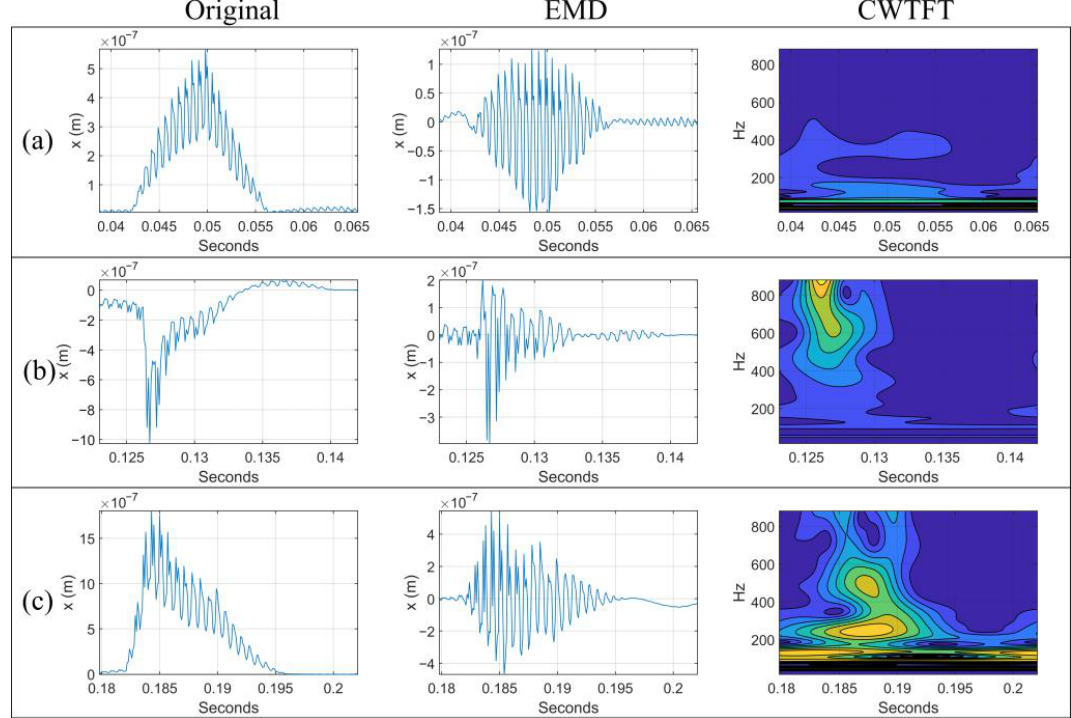
Figure 16. Time and frequency response of the rail in the longitudinal direction at different locations: ( a ) 𝐧 𝟐𝟏𝟒 , ( b ) 𝐧 𝟓𝟒𝟐 , and ( c ) 𝐧 𝟕𝟗𝟎 . The first two IMFs were chosen.